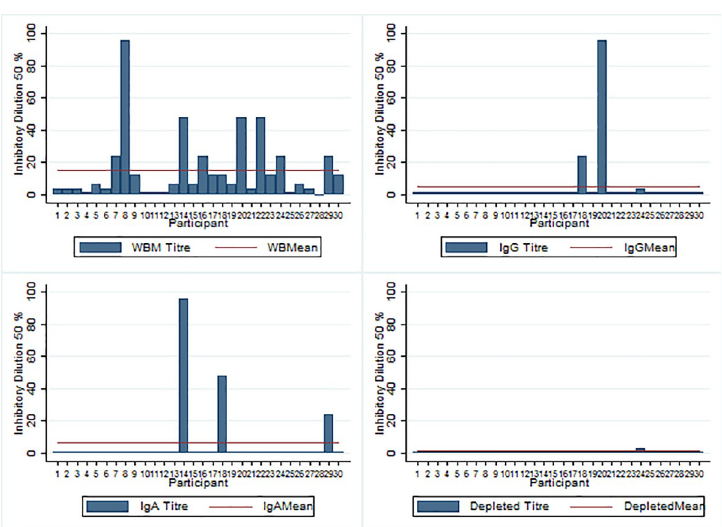
Fig 3. 50% Inhibition dilution titer by individual sample for each breastmilk samples (Whole breastmilk, purified IgG, purified IgA, and IgA and IgG depleted breastmilk) that inhibited viral replication by 50% compared to virus only control. The red horizontal line shows the mean 50% inhibition dilution titer.